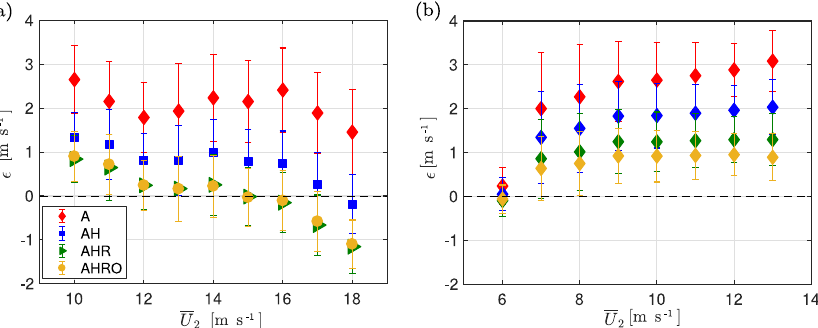
Figure 12. Forecasting error dependency on wind speed for the advection models A, AH, AHR and AHRO for neutral (a) and stable (b)